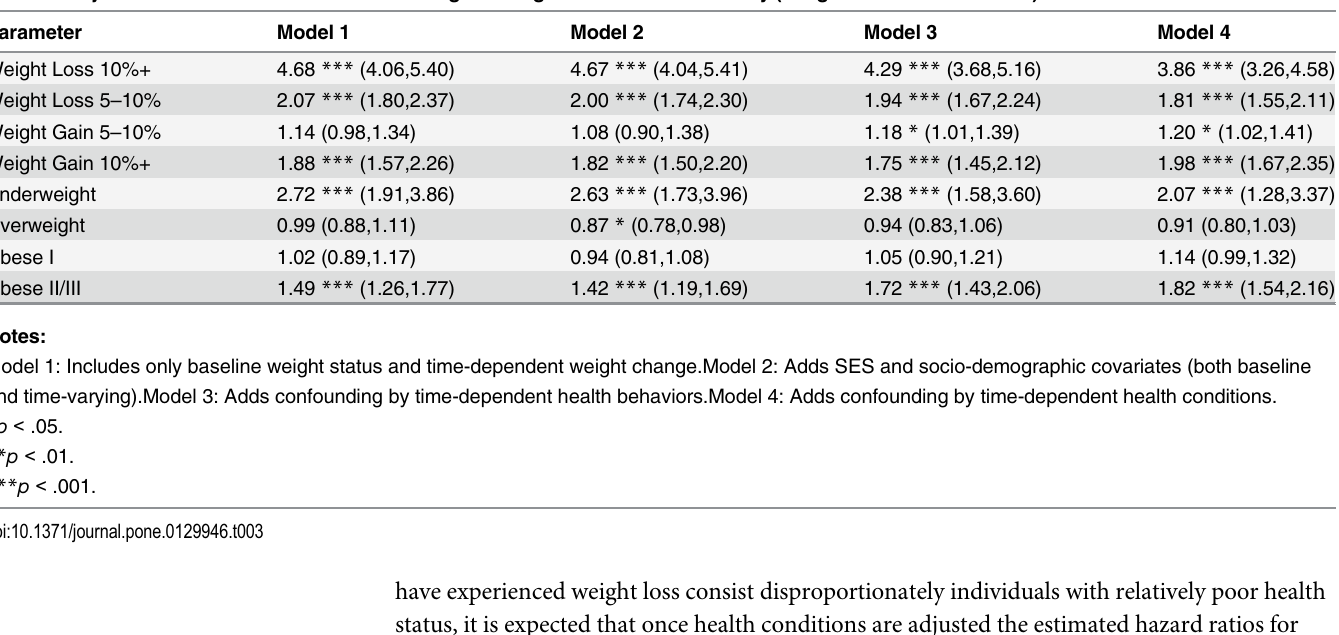
Table 3. Adjusted Effects of Baseline BMI and Weight Change Over Time on Mortality (Marginal Structural